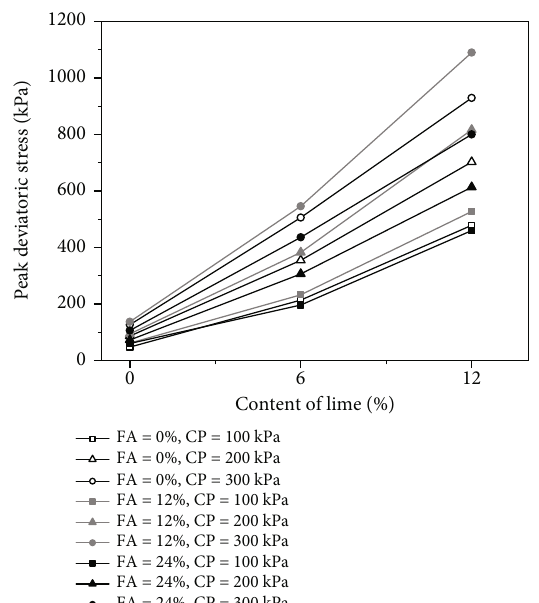
Figure 25: Peak deviatoric stress at di ff erent lime contents ( FT = 60 ).